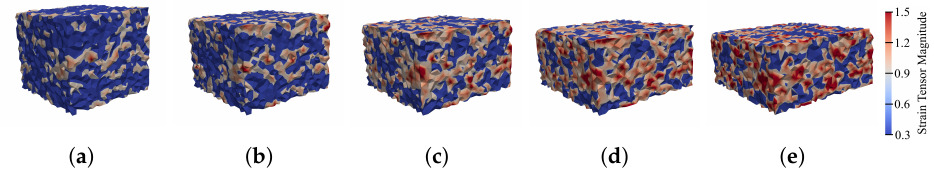
Figure 10. The micro-strain contour evolution during the compaction process of specimen S 2 , ( a ) (cid:101) 3 = 0.1, ( b ) (cid:101) 3 = 0.2, ( c ) (cid:101) 3 = 0.3, ( d ) (cid:101) 3 = 0.4, ( e ) (cid:101) 3 =